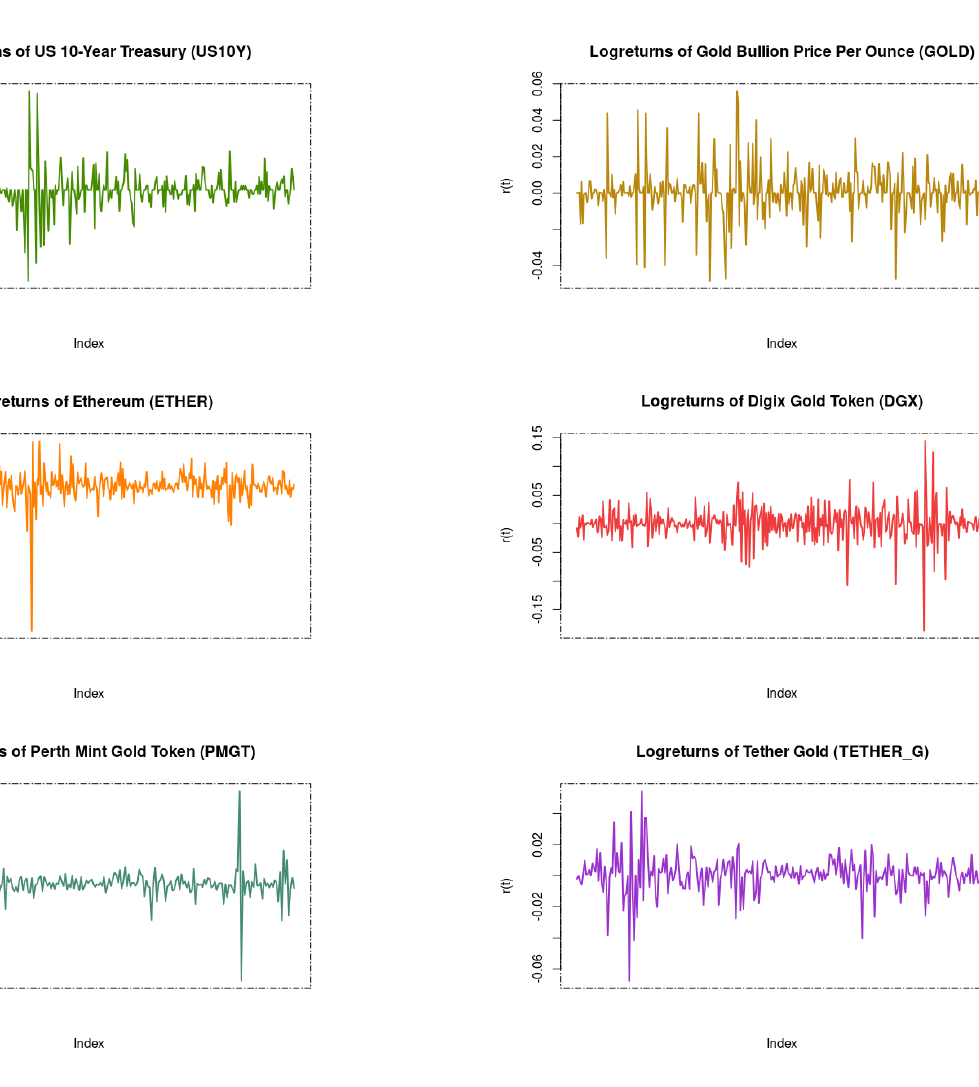
Figure 19. Stationary log-returns for safe-haven